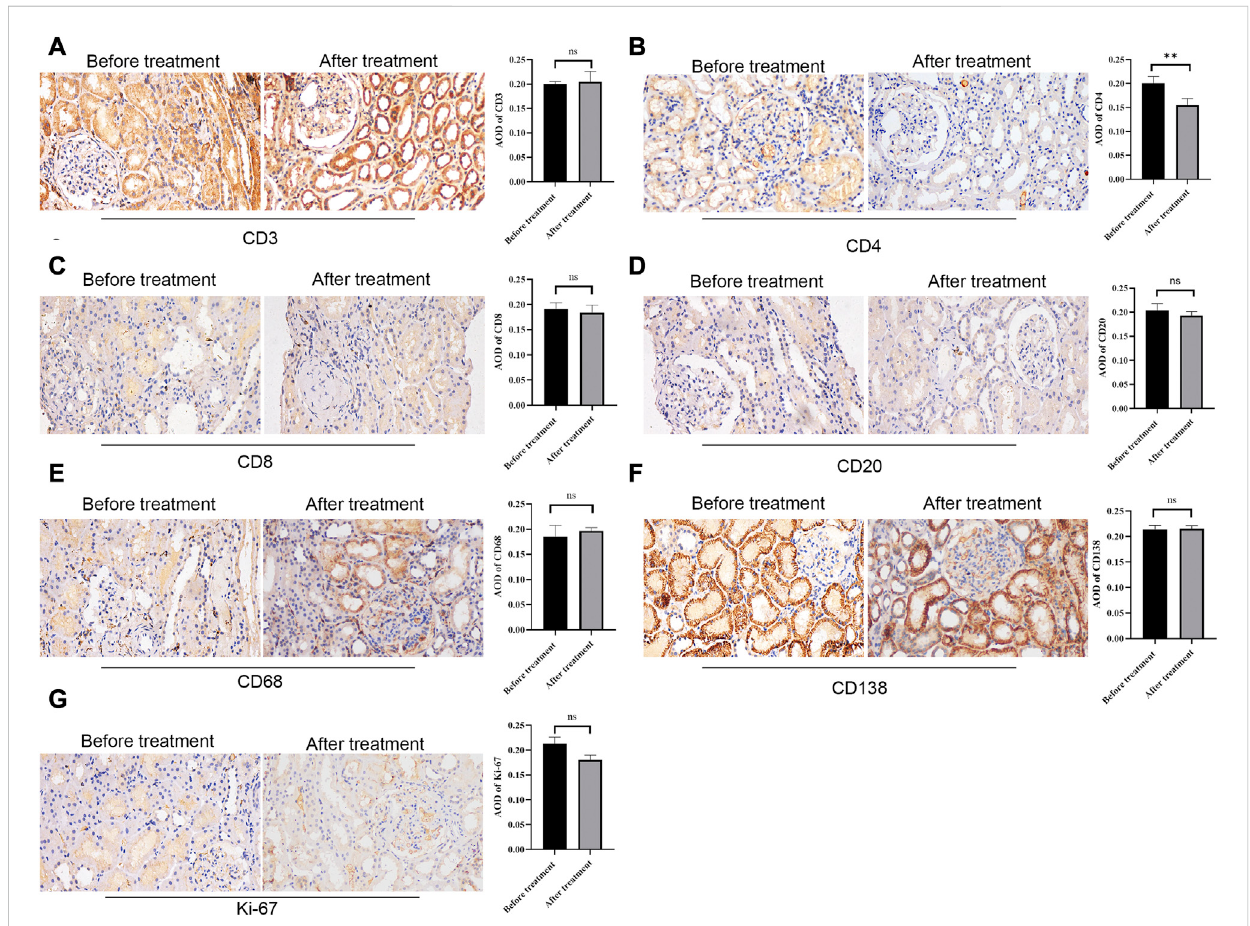
FIGURE 5 Immunohistochemical staining of CD3, CD4, CD8, CD20, CD68, CD138, and Ki-67 before and after treatment. Representative glomerulus photomicrograph in patients with repeat renal biopsy. Scale bar: 50 μ m. ** P < 0.01. ns, no signi fi